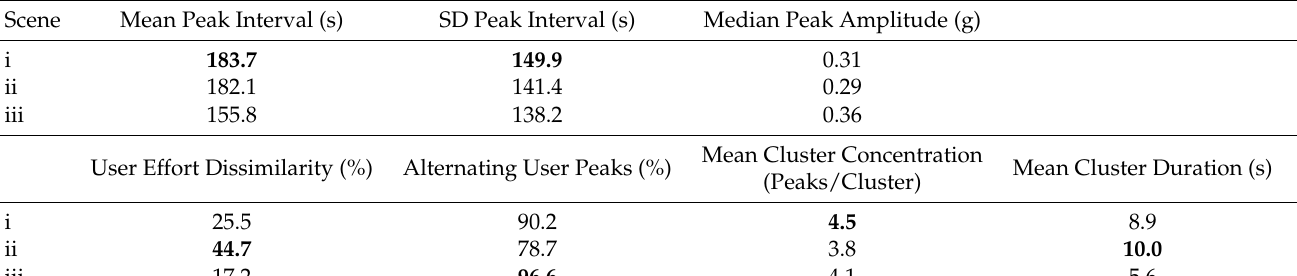
Table 1. Peak and cluster statistics from each scene, calculated from the individual user acceleration data that correspond to rows (2) and (3) in Figure